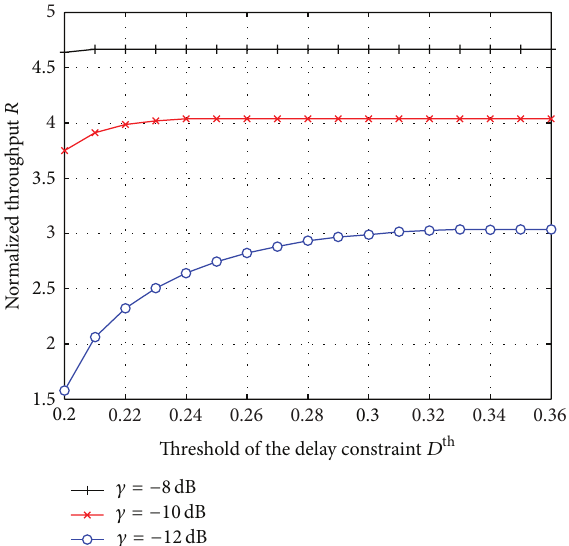
Figure 7: Normalized throughput R versus threshold of the delay constraint with different values of 𝛾